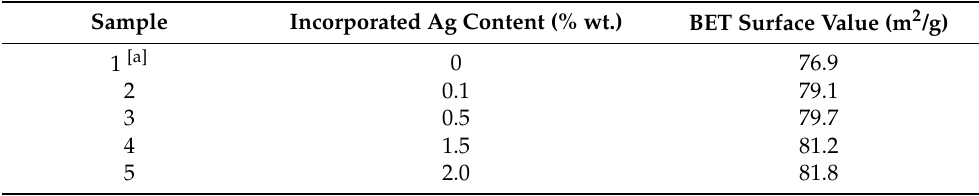
Table 3. Textural properties (N 2 , 77K) of K–OMS–2 and [Ag]–K–OMS–2